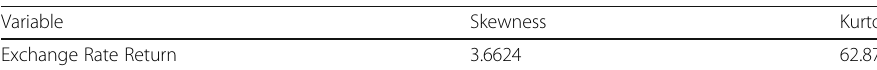
Table 10 Skewness and Kurtosis of exchange rate return